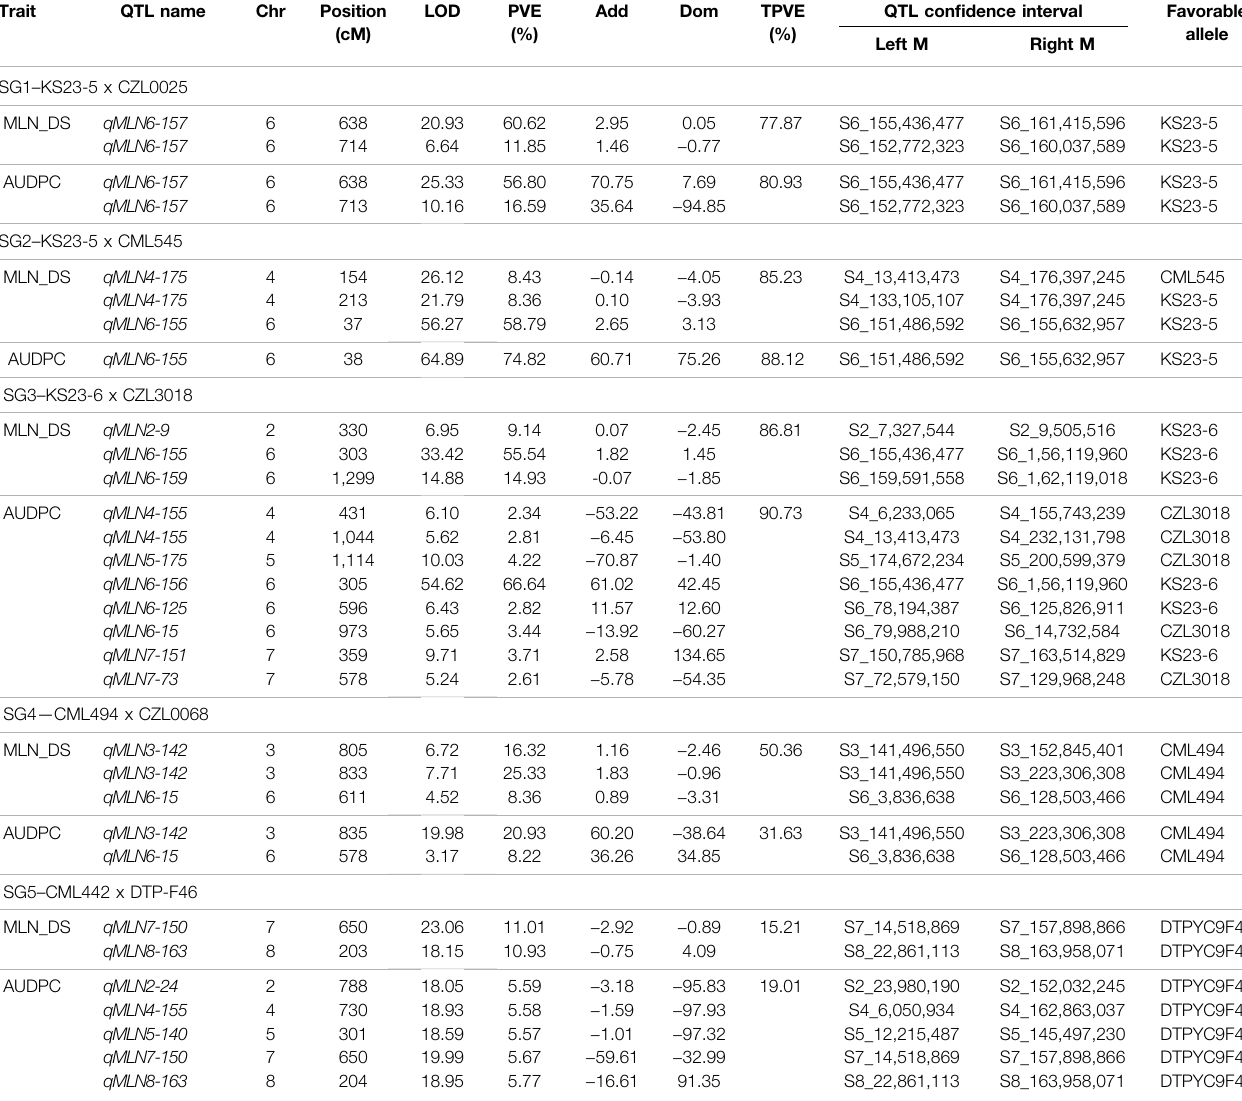
TABLE 3 | QTL associated with MLN disease severity, and AUDPC value in fi ve selective genotyping (SG) F2 populations.